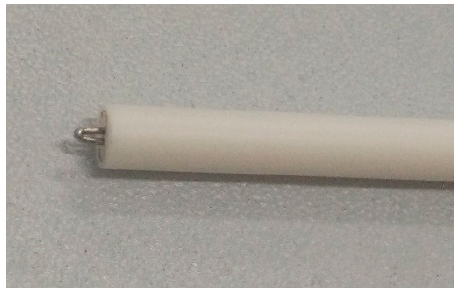
Figure 7. K-type thermocouple wire.